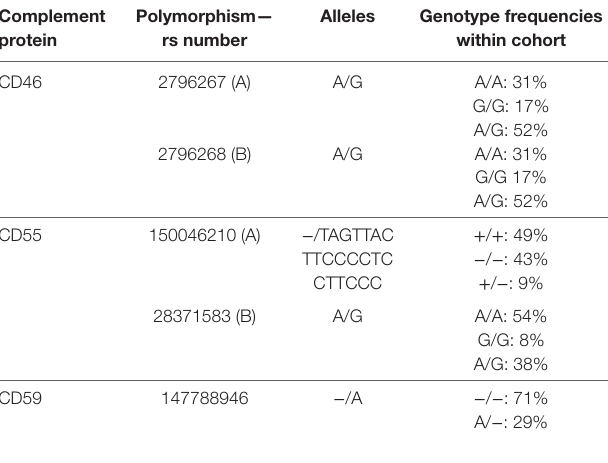
TaBle 1 | Overview of studied polymorphisms. complement protein